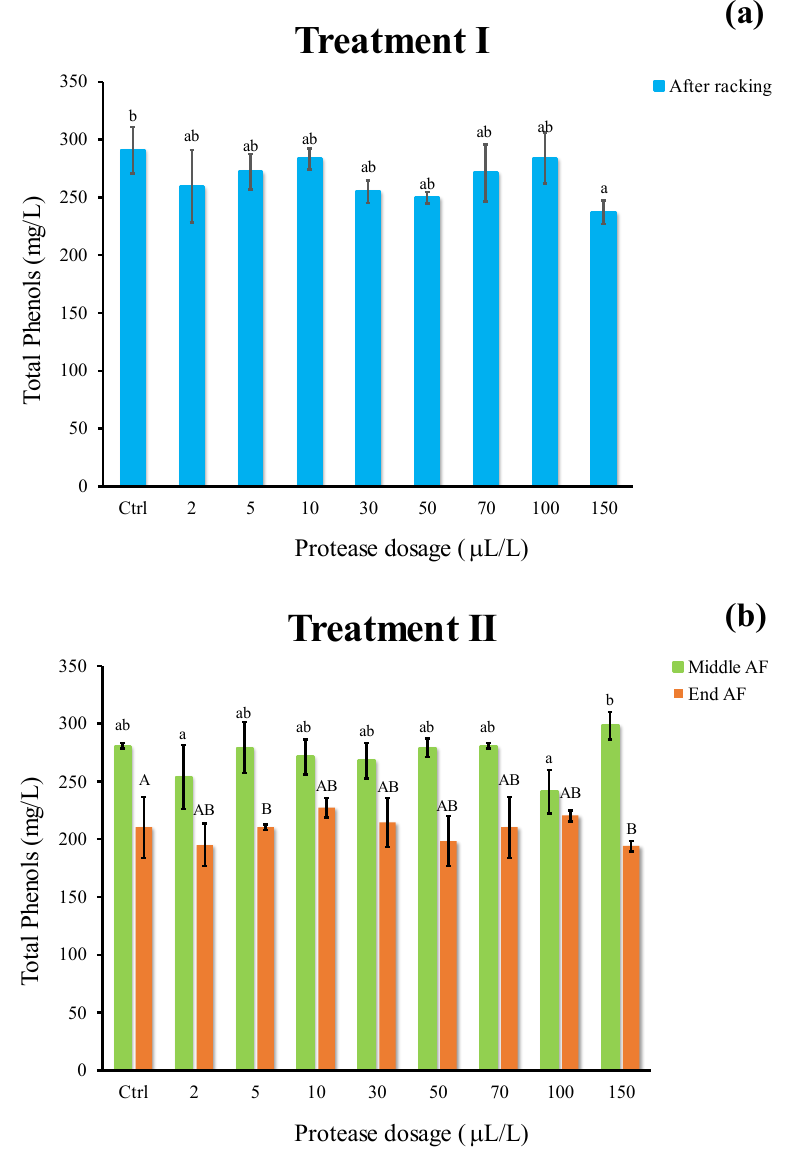
Figure 7. Total phenols (mg/L) of white must wine subjected to enzymatic addition (protease in the range of 2 – 150 μ L/L) after ( a ) treatment I (cold settling prior to AF) and ( b ) treatment II (at yeast inoculum). Ctrl is clarified must with the only pectinolytic enzyme. For each sample, means with different roman letters are significantly different ( p ≤